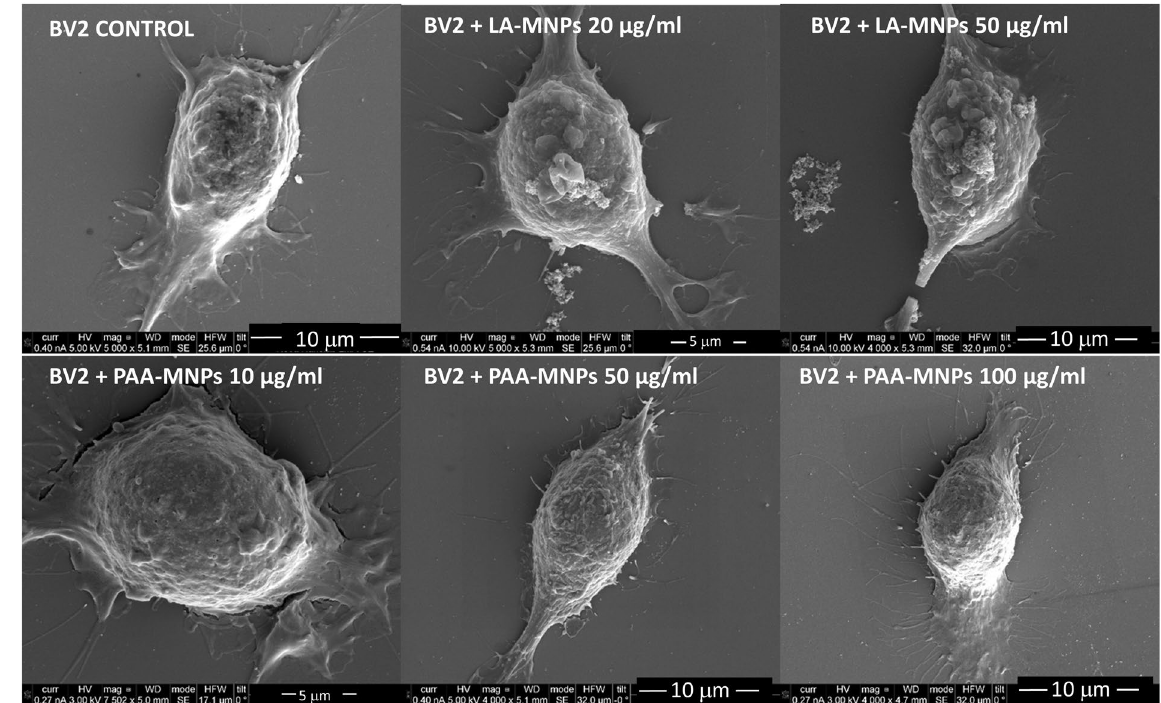
Figure 5. SEM images of BV2 cells incubated at different concentrations of PAA-MNPs and LA-MNPs during 12 h. The short projections from the cell membrane are visible, as well as the major axon-like structures extending from the two opposite ends of the cell